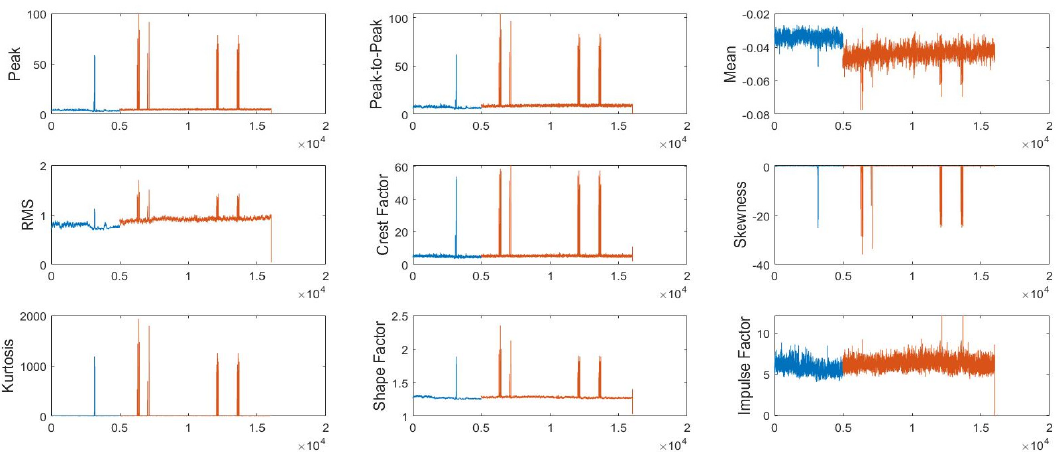
Figure 7. Features extracted from signal 1 in setting 1 (blue) and setting 2 (orange) .